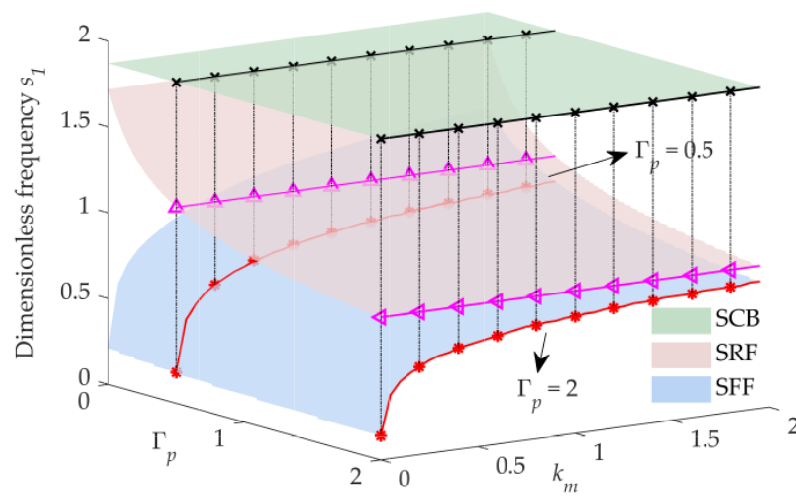
M ). k and  ( = 0 . 1 p p m